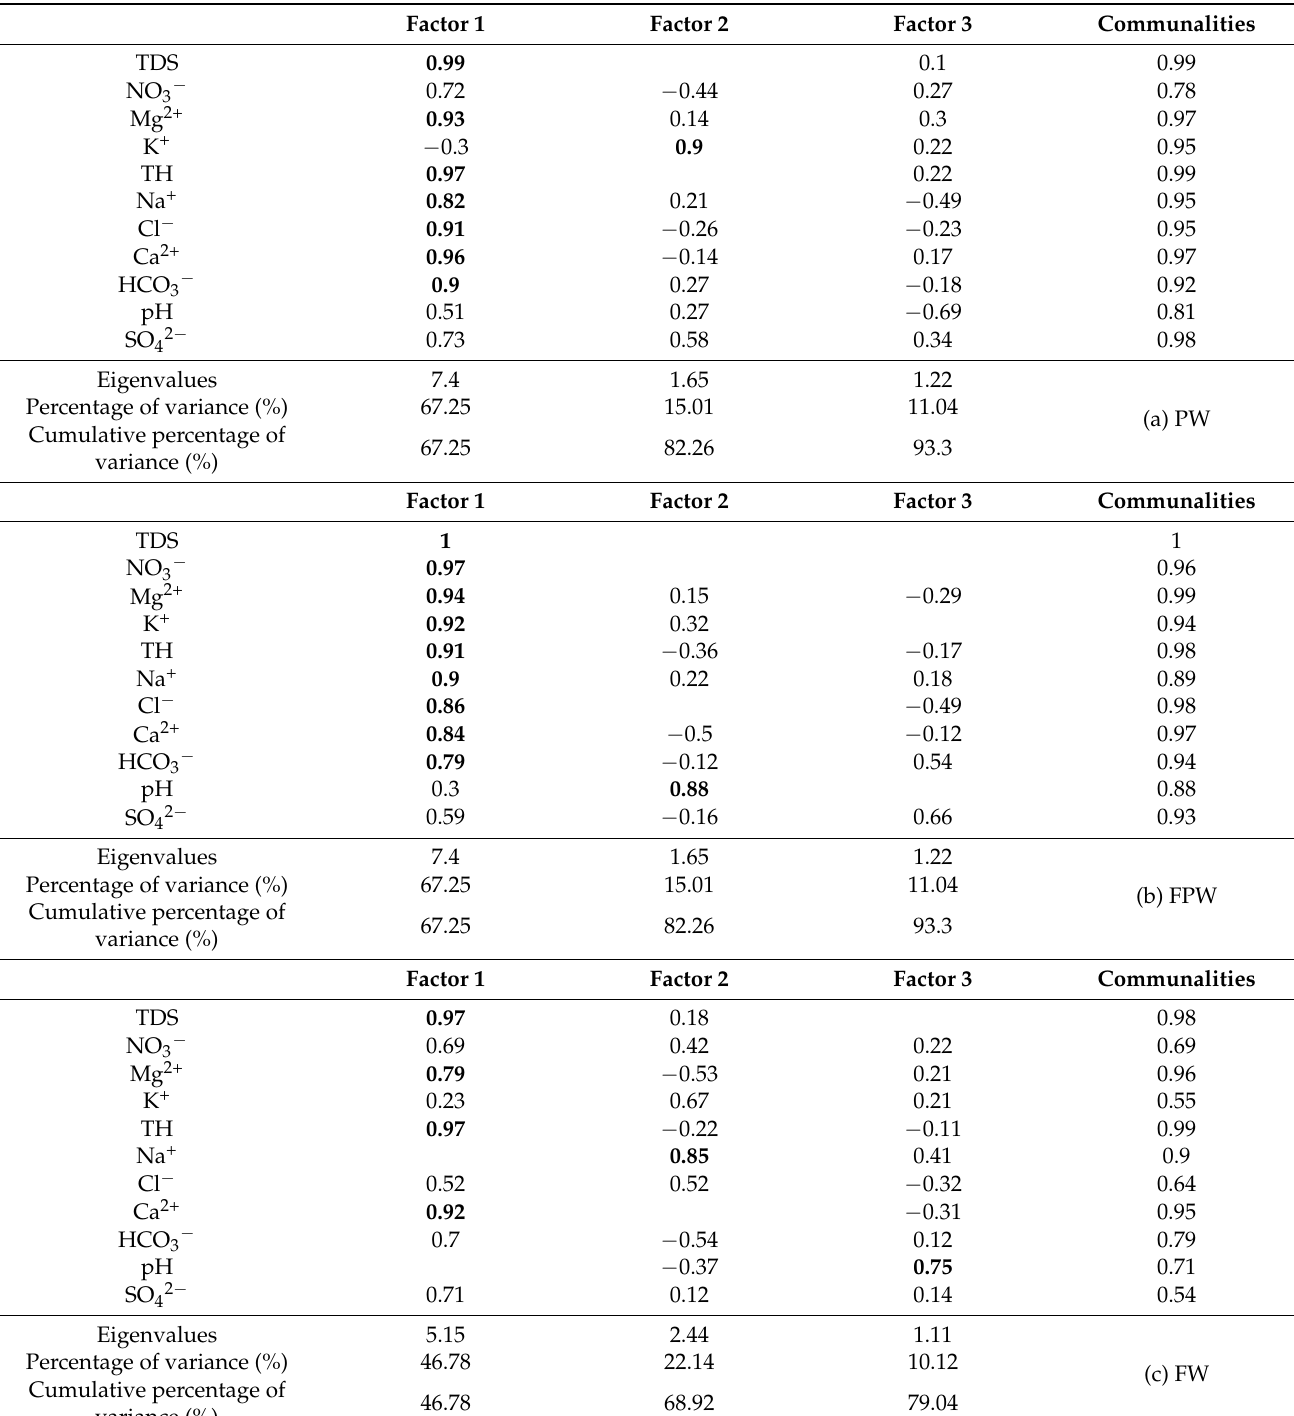
Table 2. Factorial load (absolute strong load ( ≥ 0.75) in bold) and the corresponding communality (top half of the table). Cumulative percentage of factor eigenvalues, percentages, and variances (bottom half of the